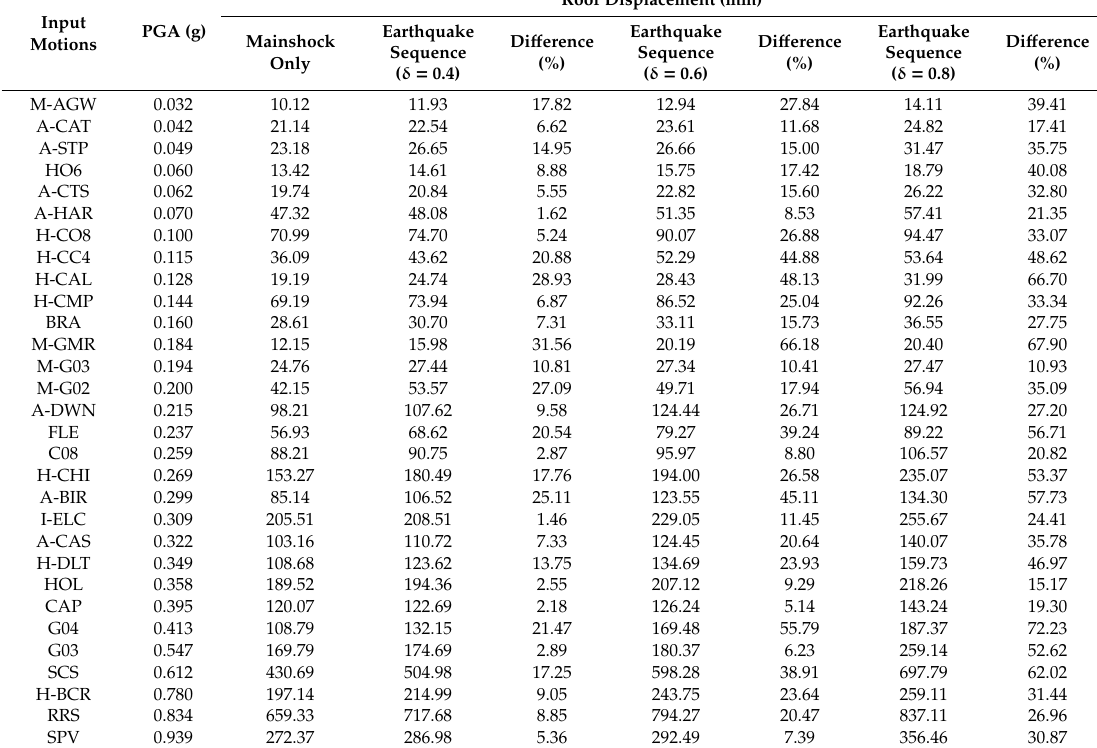
Table 3. Maximum roof displacement under mainshock and earthquake